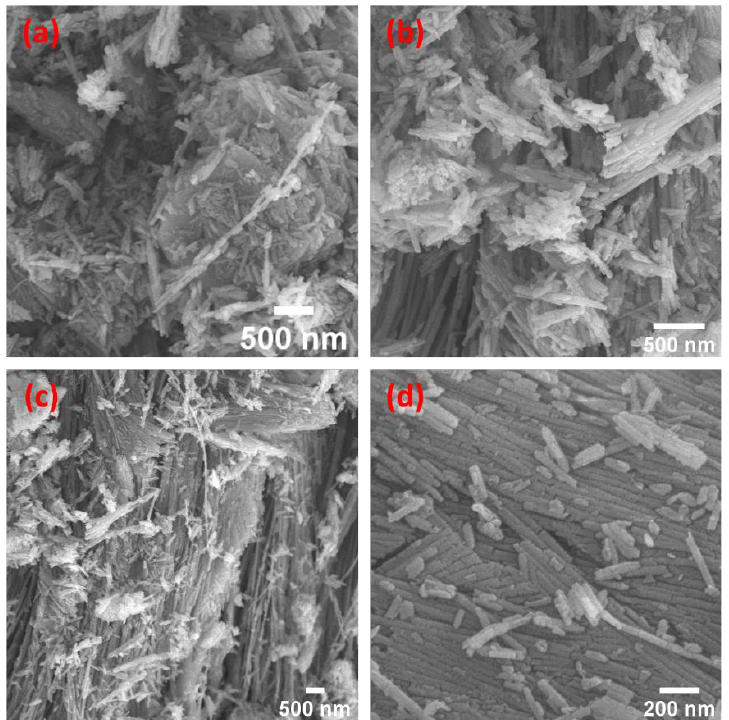
Figure 4. ( a – d ) FESEM images at different areas showed nanofibrils with different lengths in the serpentine sample that was hydrothermally treated at 250 °C for 6 h.